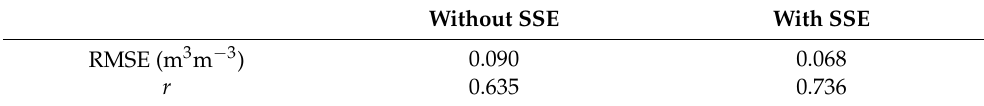
Table 6. Statistical metrics on testing dataset for SMC retrieval with and without the SSE